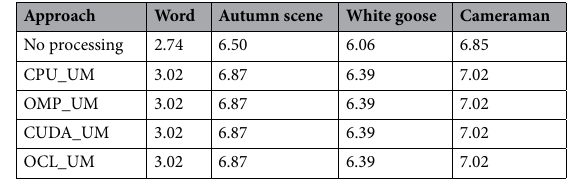
Table 3. Comparison of image information entropy in different UM algorithms.